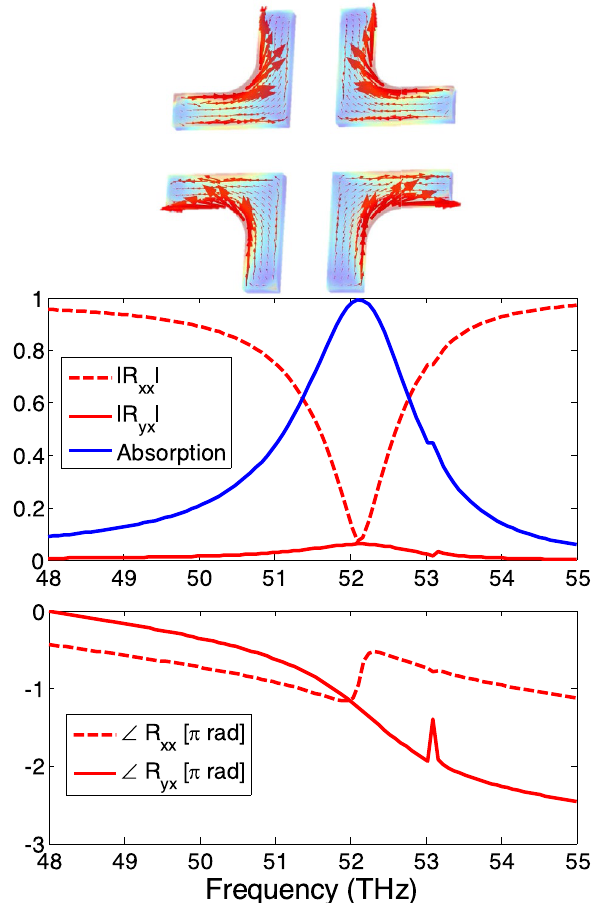
Figure 5. The co- and cross- polarized reflection coefficients of the absorbing phase-compensated metasurface (Fig. 4) along with the absorption spectrum. The inset shows the current density vectors on the supercell at the 52.2 resonance illustrating the vectorial cancellation of diametrically opposite L-elements. The chiral current distribution is provided in instantaneous time varying form in supplementary